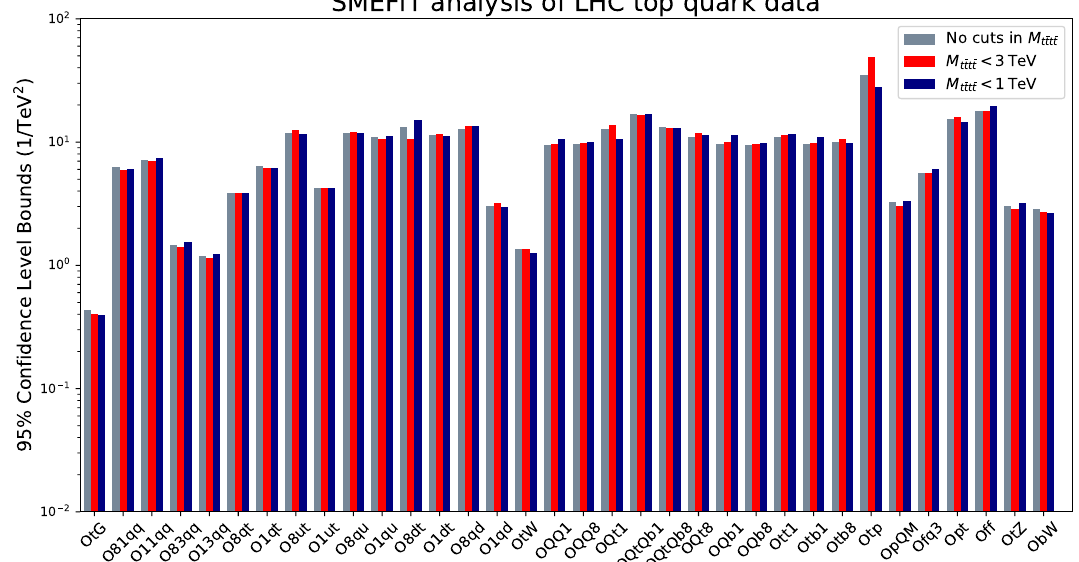
Figure 24 . Same as (cid:12)gure 19, now comparing the baseline (cid:12)t results with those obtained from two (cid:12)ts with di(cid:11)ering cuts on m used in the theoretical calculation of the t (cid:22) tt (cid:22) t production t (cid:22) tt (cid:22) t